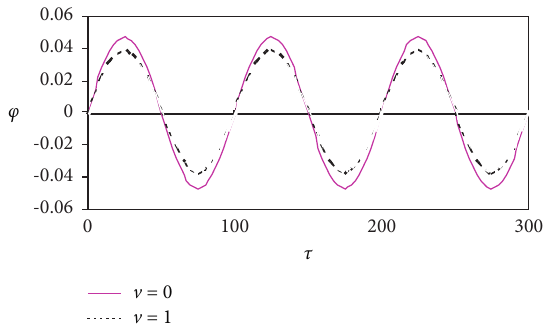
Figure 13: The numerical solutions for case (v) in Section 4.1.